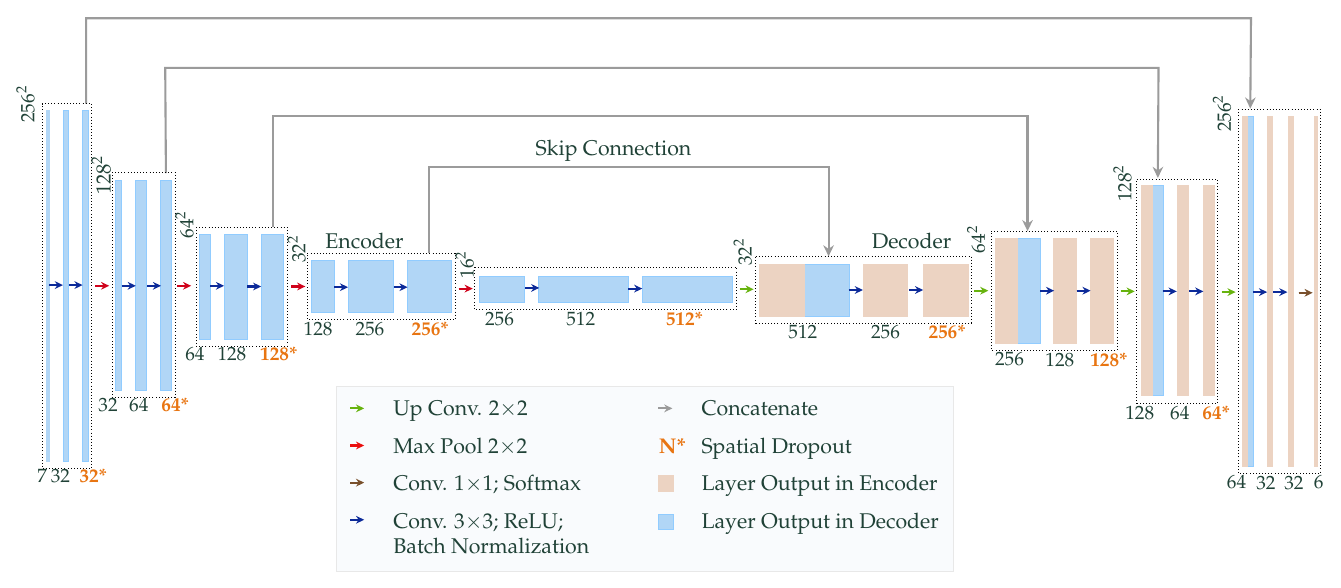
Figure 2. The U-Net architecture [14] with 32 start filters and a depth of 5, used in stage 2 of the self-training framework. The layers that constitute each encoder and decoder block are shown inside the boxes with dotted borders. The number of feature maps is indicated below each colored box. The resolution is the same for all layers in the encoder/decoder block; this is indicated at the top left of the dotted box. The output of the encoder, which is provided via the skip connection, is concatenated with the output of the up-convolution operation from the previous